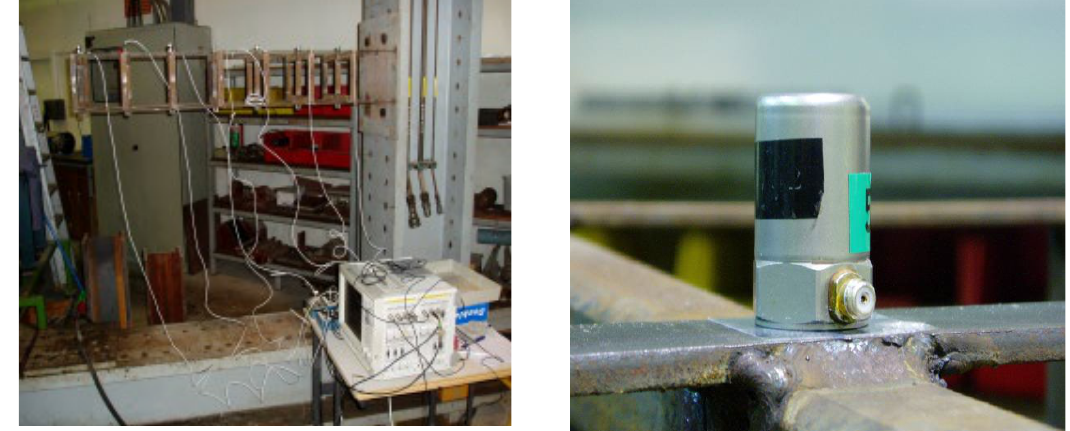
Figure 10. Testing of a seven − story steel frame structure.